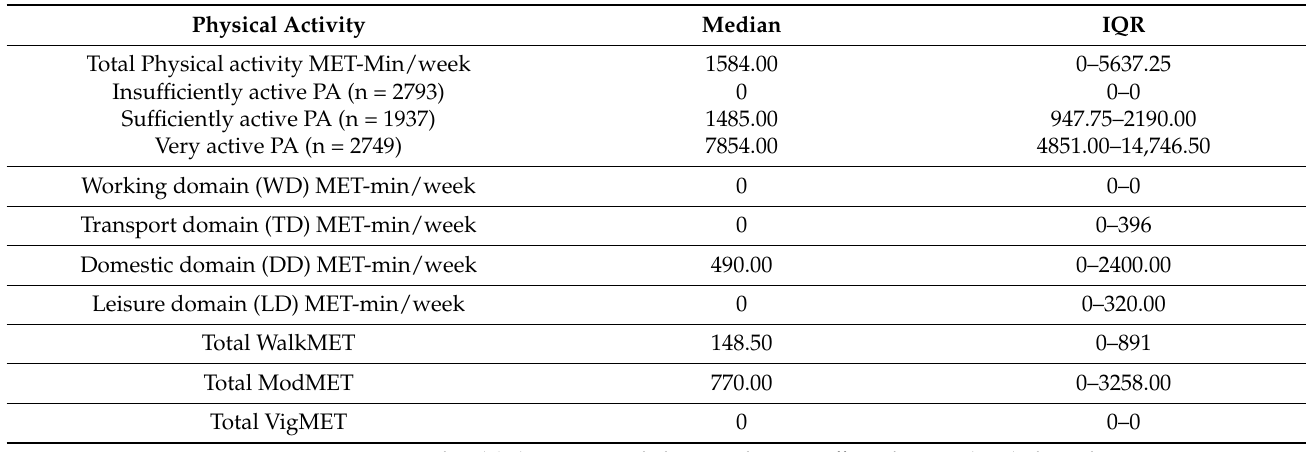
Table 2. Distribution of insufficiently active, sufficiently active and very active physical activity across total physical activity and its 4 domains based on IPAQ.